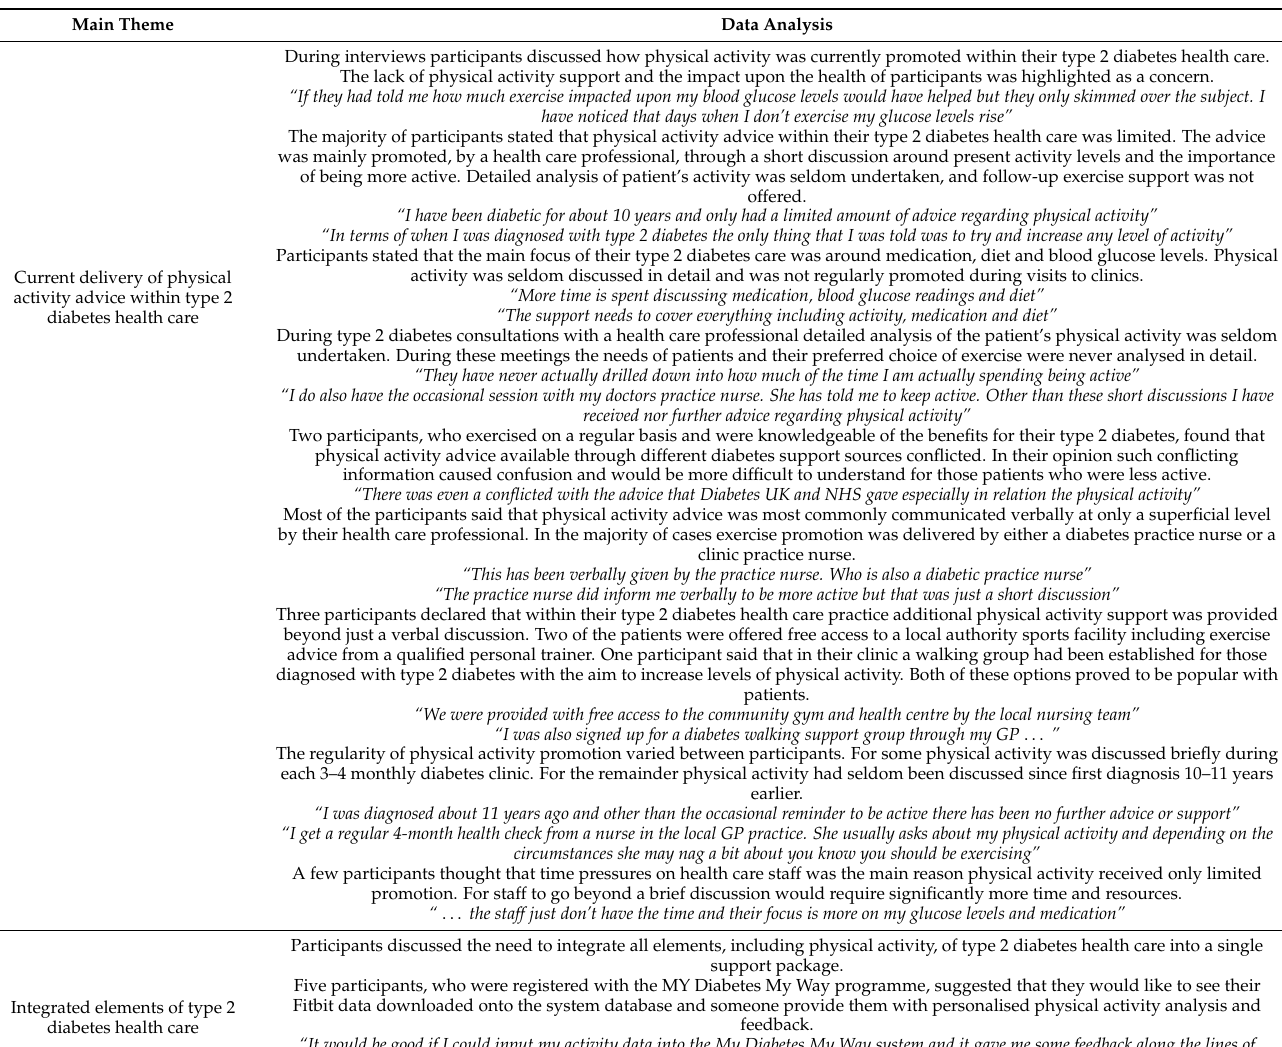
Table 3. Detailed analysis of stage 1 main